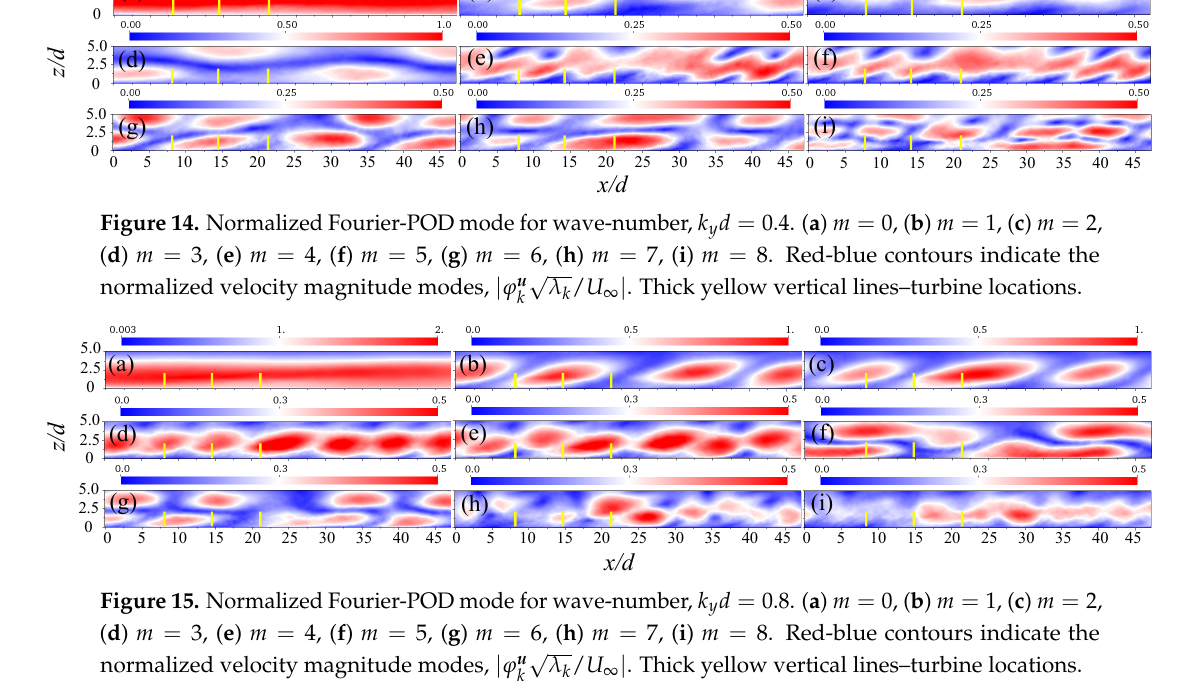
√ λ ϕ u k / U ∞ | . Thick yellow vertical lines–turbine locations. k |